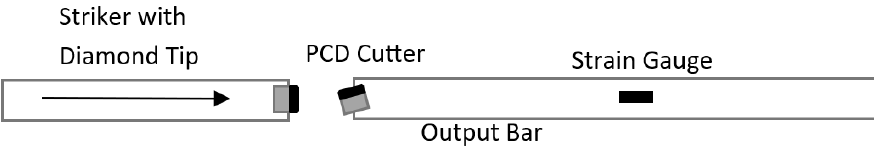
Fig. 1. Direct impact Hopkinson bar